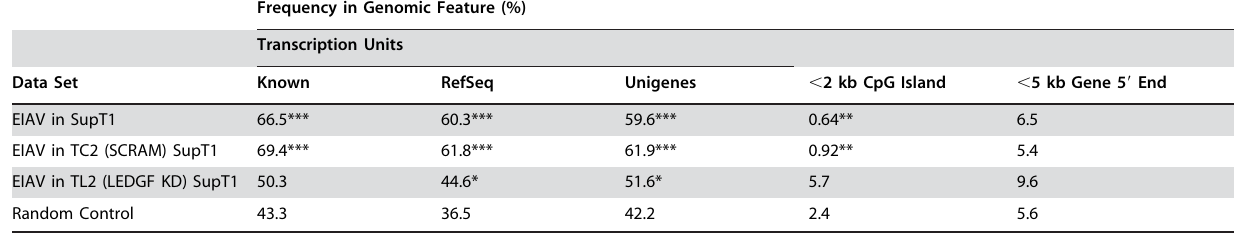
Table 2. Integration frequency in the presence and absence of LEDGF/p75 near mapped genomic features in the human genome. .. ... .... ... ... .... ... ... .... ... ... .... ... ... .... ... ... .... ... ... .... ... ... .... ... ... .... ... ... .... ... ... .... ... ... .... ... ... .... ... ... .... ... ... . Frequency in Genomic Feature